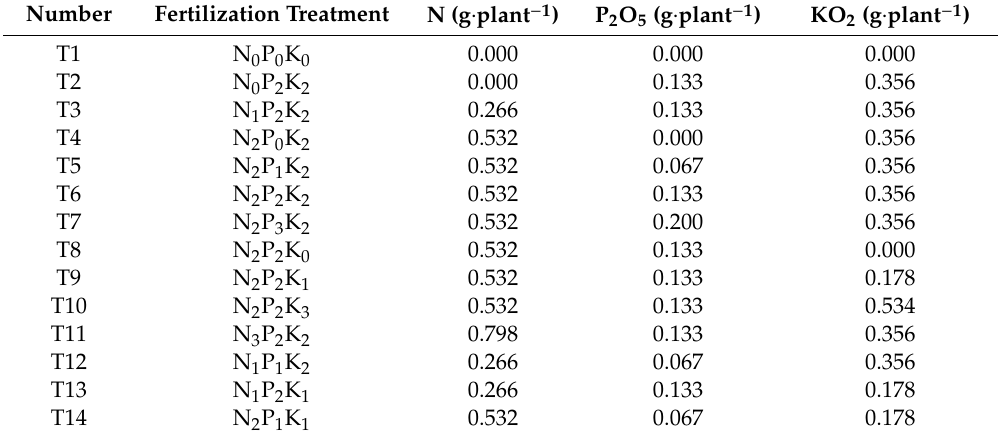
Table 2. The 14 fertilizer rates used in the “3414” Phoebe bournei seedling growth fertilization